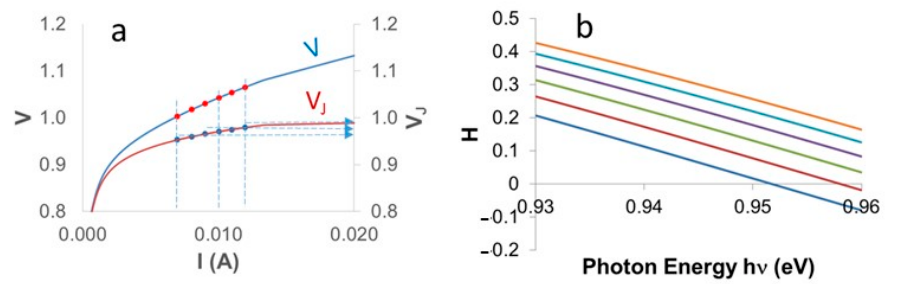
Figure 9. ( a ) Calculation of the values of V J for each spectrum in Figure 8a; ( b ) the corresponding H functions according to Equations (21) and (24).